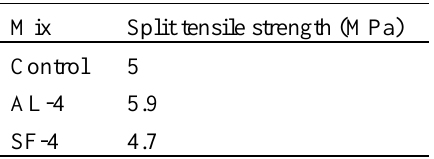
Split tensile strength results of Optimum